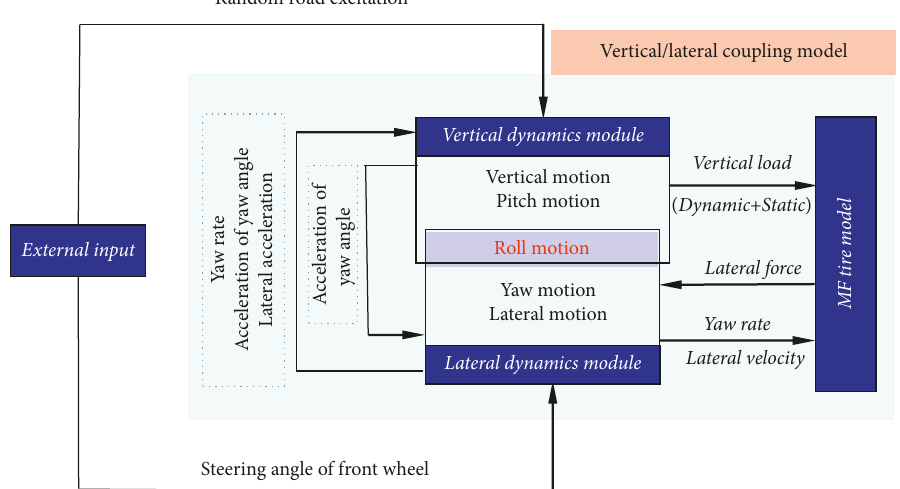
Steering angle of front Figure 1: Structure of vertical/lateral coupling dynamics model of heavy